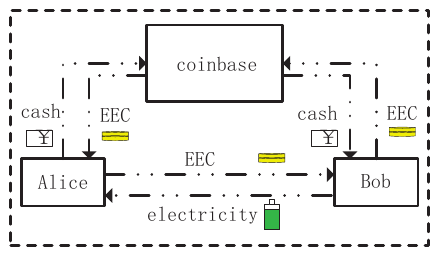
Figure 10. Electricity Energy Coin (EEC)